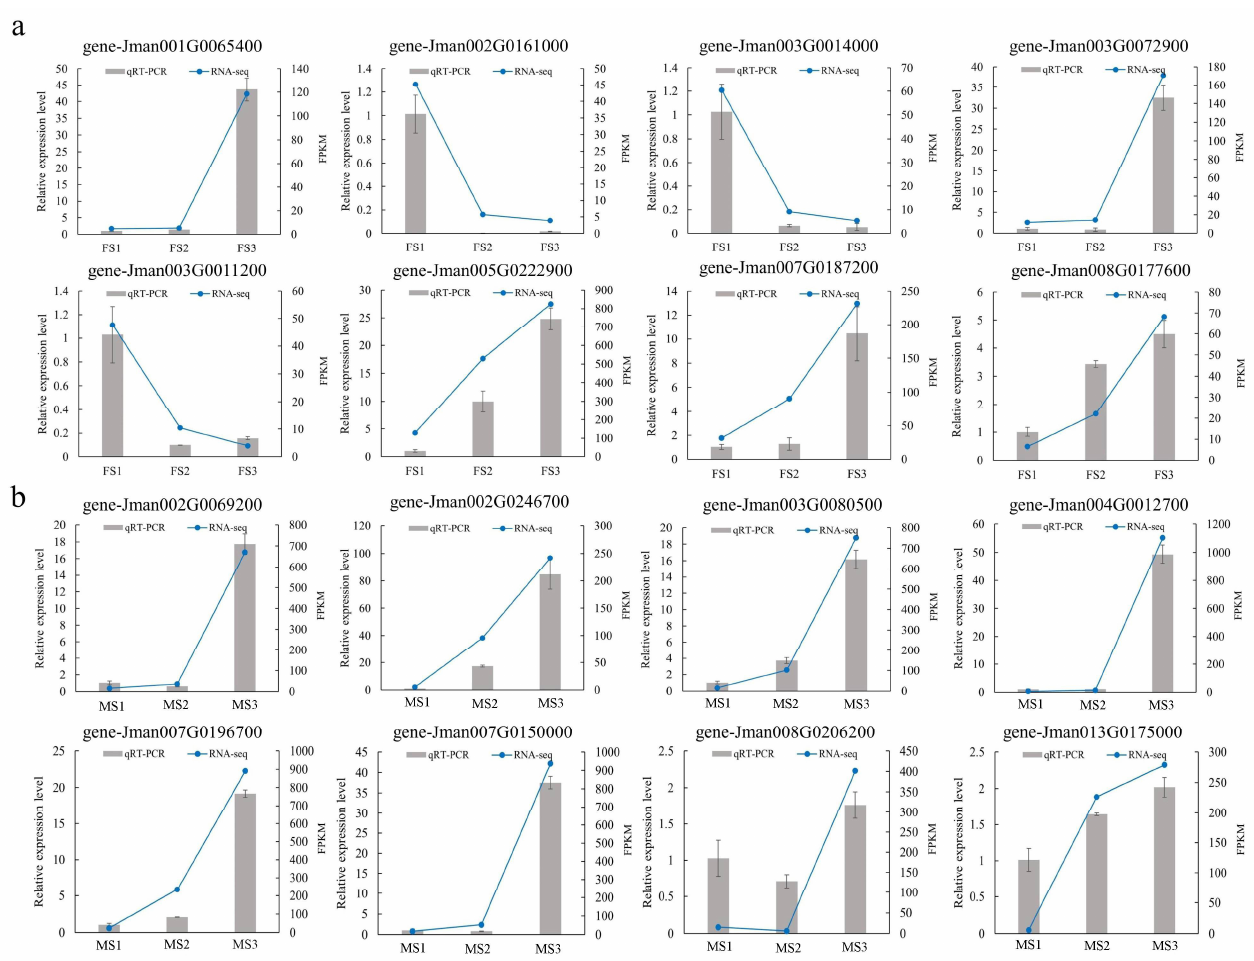
Figure 11. RT-qPCR verification of expression level of 16 DEGs identified by RNA sequencing. ( a ) RT-qPCR verification of eight DEGs during female development; ( b ) RT-qPCR verification of eight DEGs during male development. The Y -axis on the left indicates the relative gene expression levels (2 −−ΔΔCt ) analyzed by qRT-PCR, while the Y -axis on the right represents the FPKM value obtained by RNA-seq. The X -axis represents the different developmental stage samples.